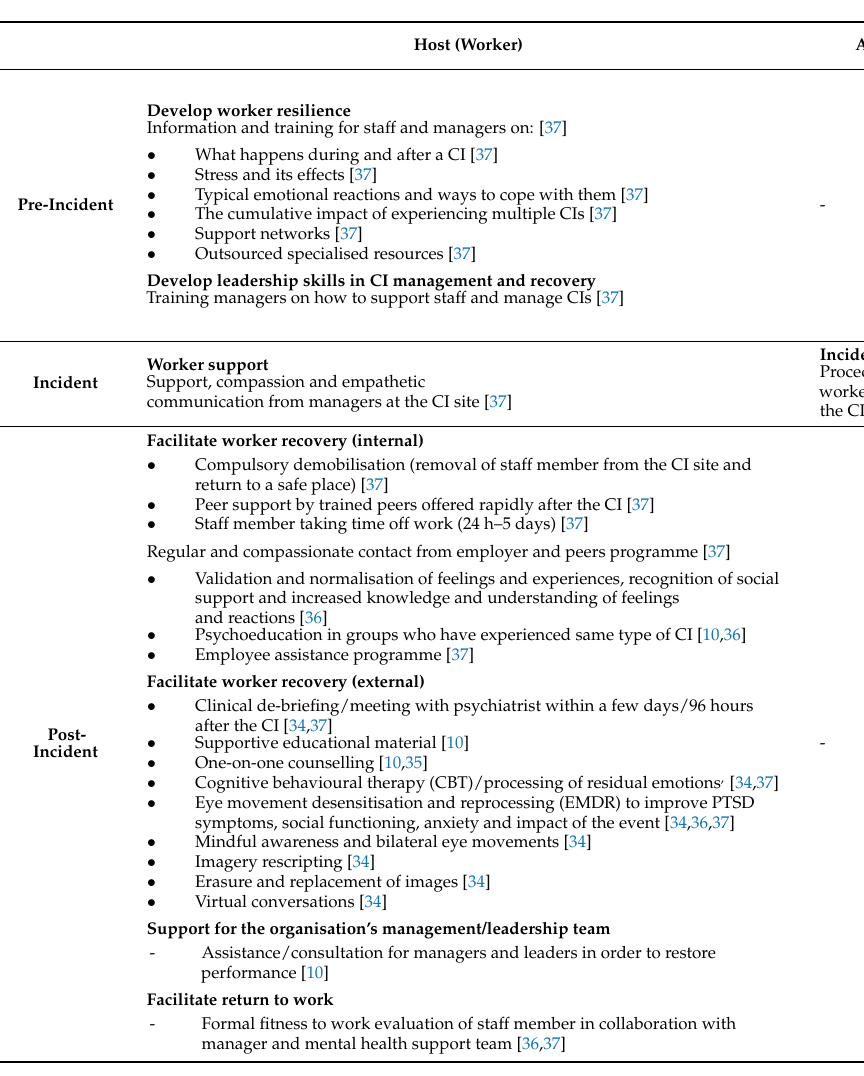
Table 3. Haddon’s matrix of workplace interventions to respond to critical